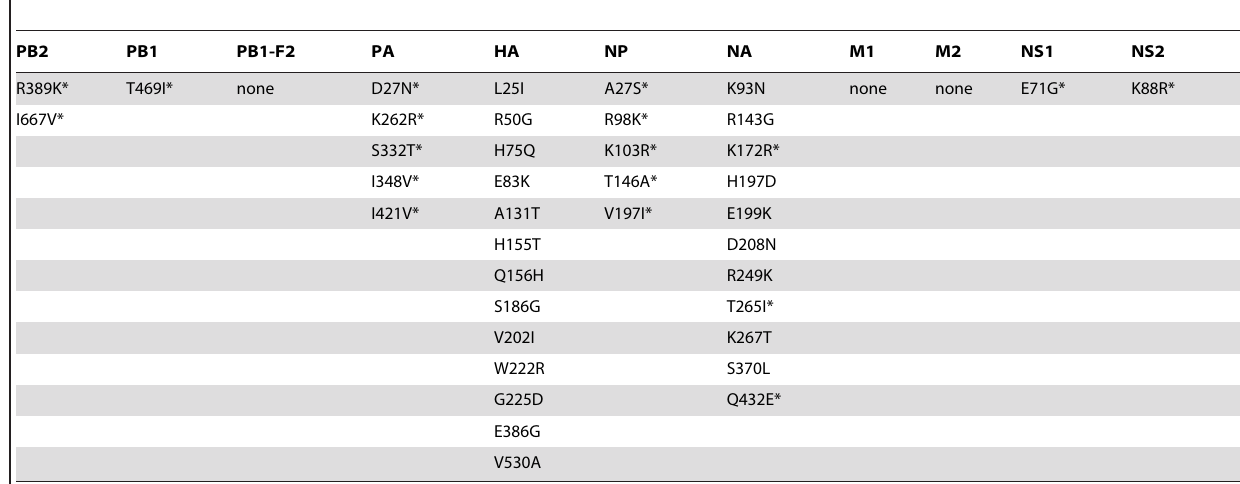
Table 1. Amino acid substitutions in the inferred protein sequences that distinguish UK Fujian/411-like viruses from earlier (Panama/2007-like)